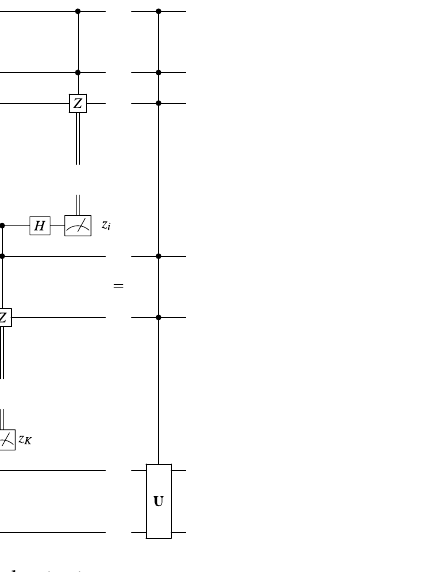
Figure 4. Cascade distribution of controlled